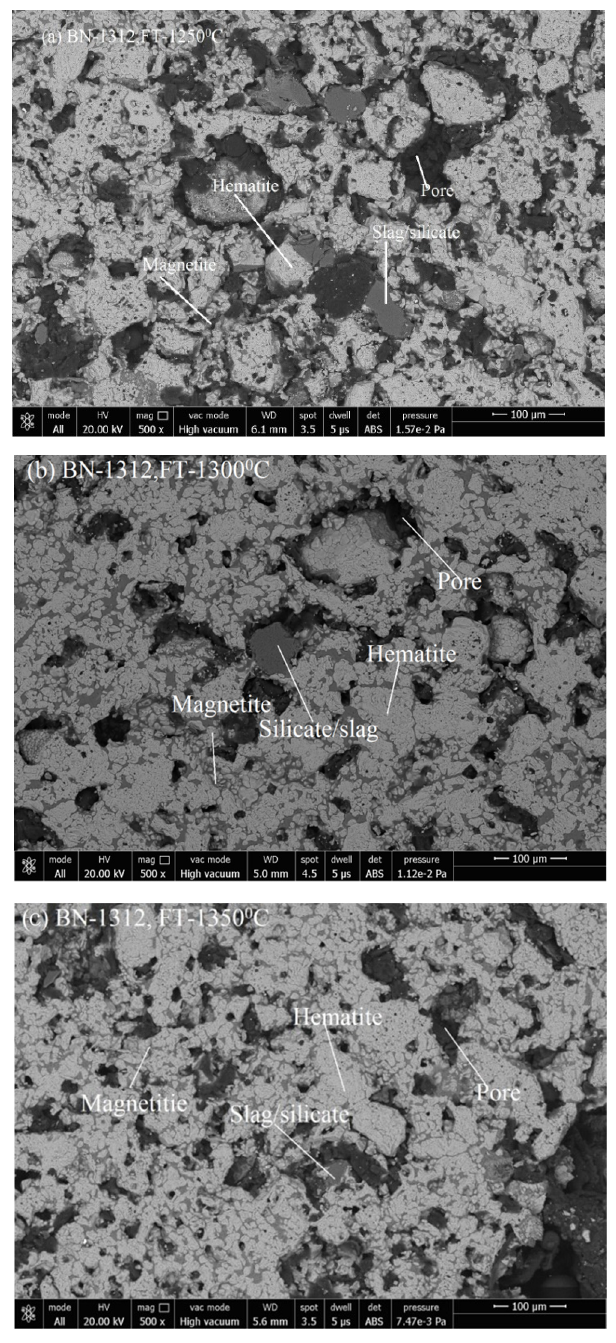
Figure 5. SEM Microstructure of ( a ) K1A, ( b ) K1B, ( c ) K1C, ( d ) K2A, ( e ) K2B, and ( f ) K2C pellets.